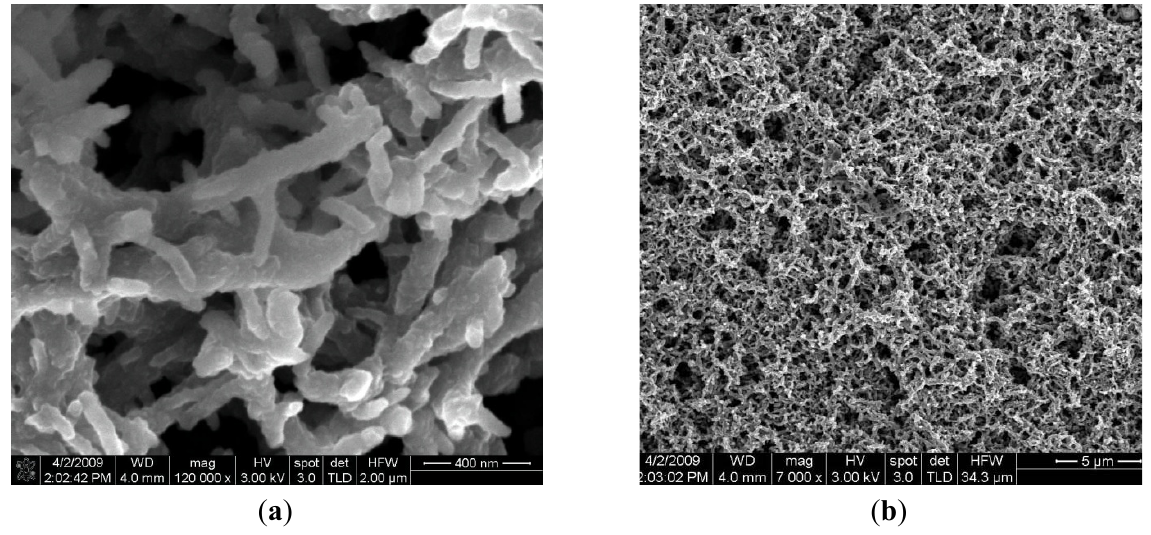
Figure 5. SEM pictures of the polyaniline conductive layer deposited on Ti/Pt